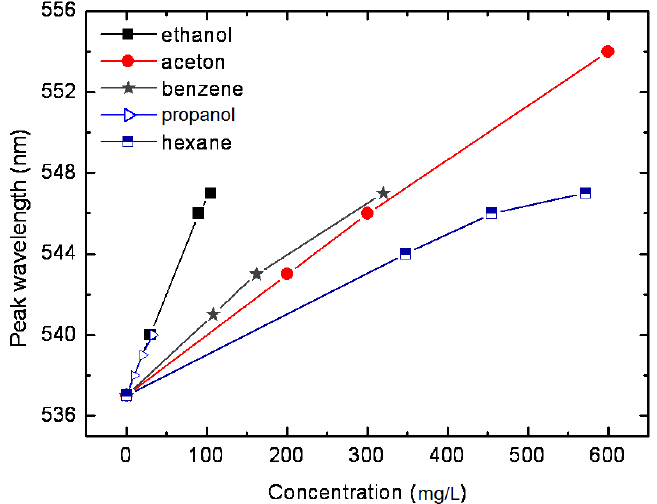
Figure 6. Calibration sensitivity curves of peak wavelength response to concentrations of five test vapors.